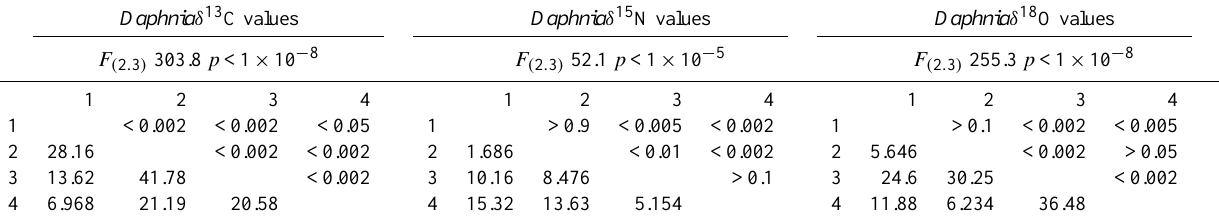
Table 1. Results of the tests for statistical differences between the four (1–4) treatments (one-way ANOVA) and between pairs of treatments (Tukey test) for δ 13 C Daphnia , δ 15 N Daphnia and δ 18 O Daphnia values. The results of the Tukey test are presented below the F and p values for the one-way ANOVA, showing Q values (lower left part of matrix) and p values after Bonferroni correction (upper right). Daphnia δ 13 C